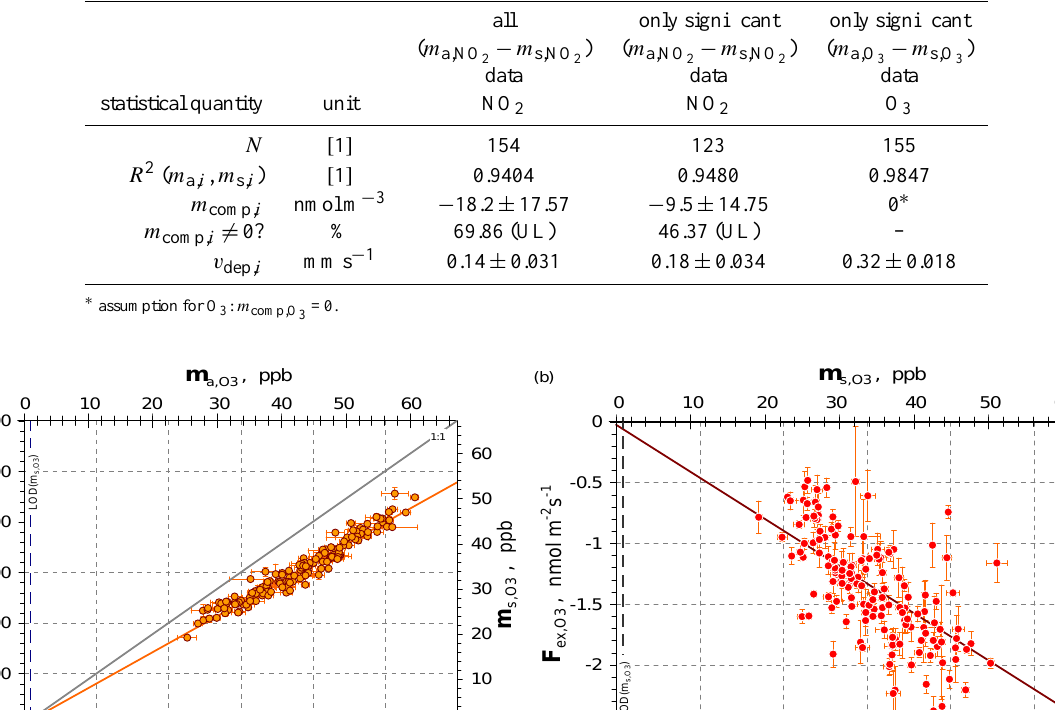
). Orange circles identify data pairs for significance of 1m O 3